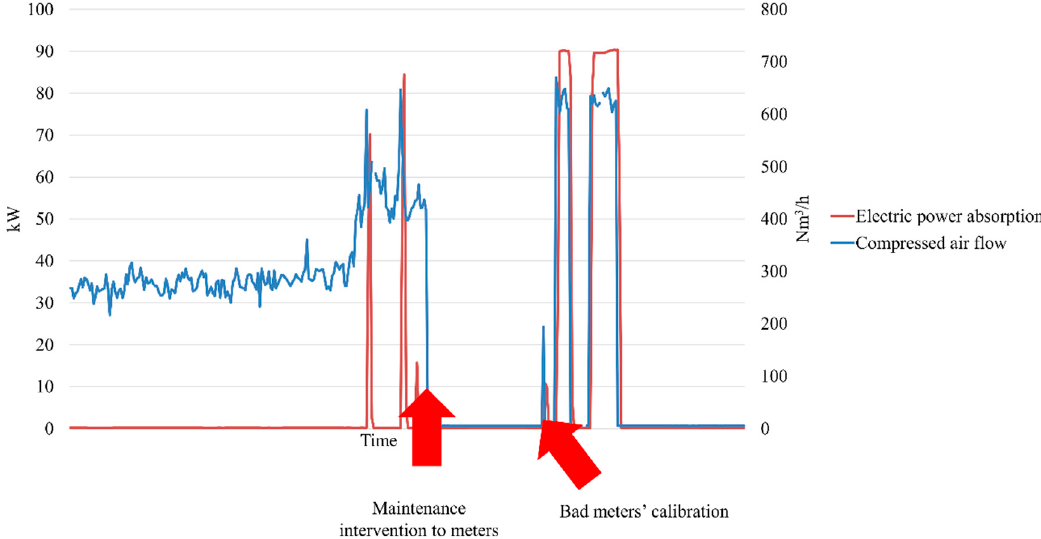
Figure 6. Maintenance issues to compressed air meters (data at a 15 minute frequency).